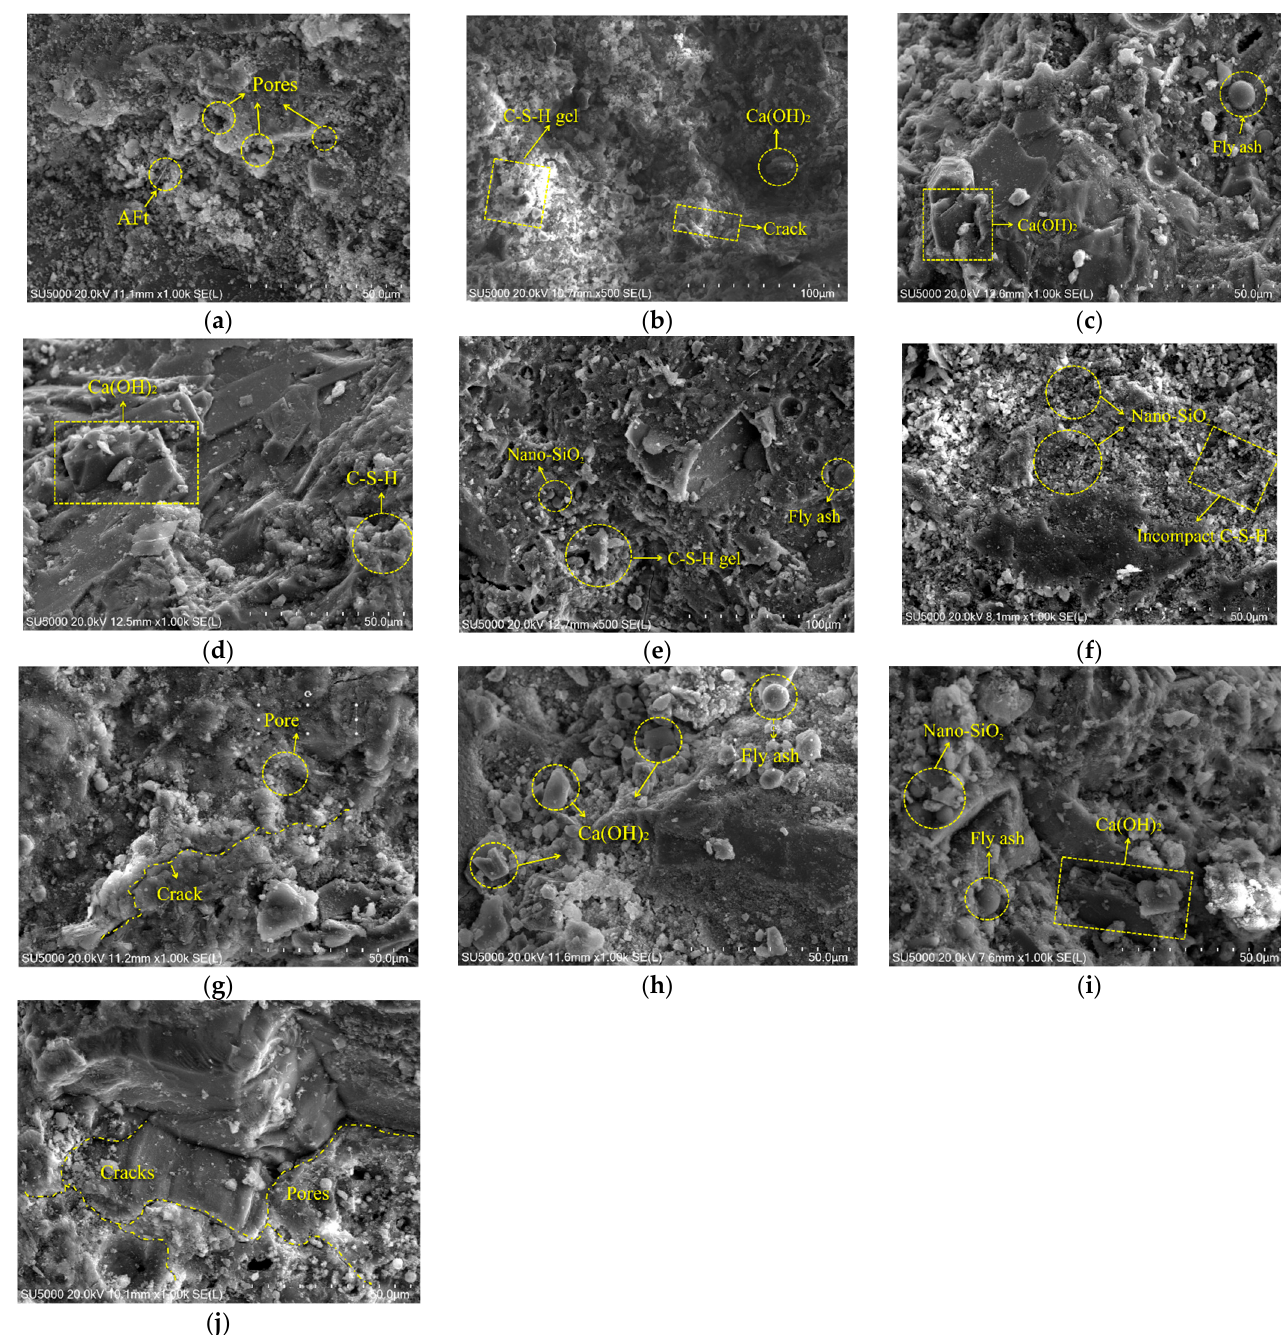
Figure 5. SEM results of concrete with different dosages of nano-SiO 2 and polypropylene fiber after 28 days curing. ( a ) NC, ( b ) PFC, ( c ) PF-NS1, ( d ) PF-NS3, ( e ) PF-NS5, ( f ) PF-NS7, ( g ) PF6-NS3, ( h ) PF12-NS3, ( i ) L-PF-NS3, and ( j ) H-PF-NS3.